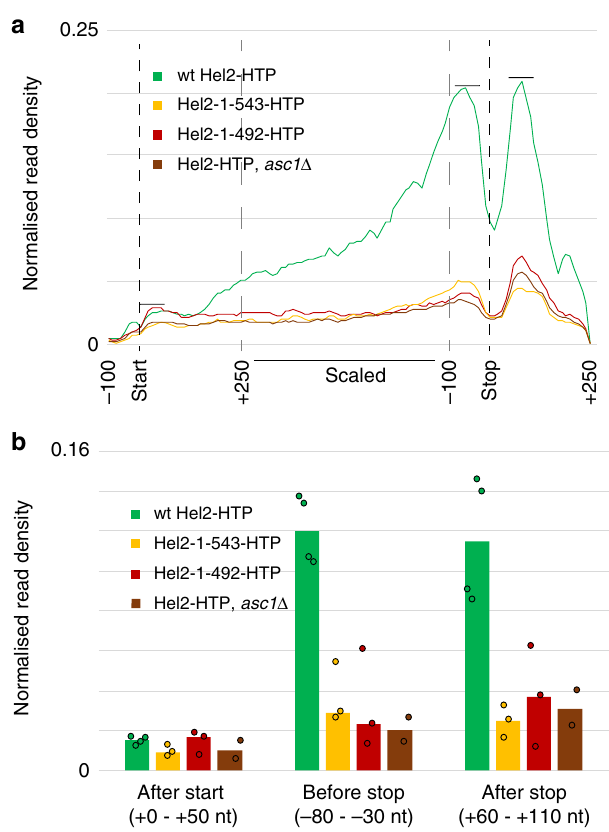
Fig. 9 Effect of Hel2 mutations and asc1 Δ on Hel2 mRNA crosslinking. Effects determined for top 252 reproducibly Hel2-bound mRNAs of transcript length >500 nt and open reading frame length >350 nt. a Metagene representation of read density over mRNAs from Start − 100 nt to Stop + 250 nt with nucleotides between start codon + 250 nt and